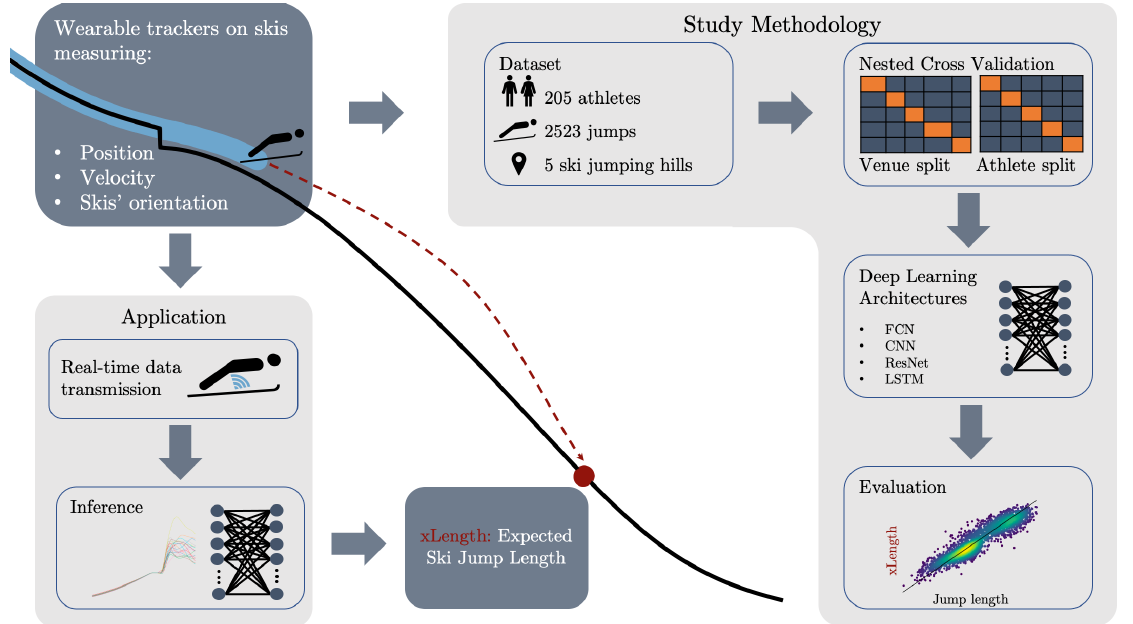
Figure 1. Two wearable trackers are mounted on the athletes’ skis. They measure the 3D position, 3D velocity, and 3D orientations of the skis. In a later application, the data are transmitted in real time and are used to predict the expected jump length (xLength) using deep learning. Additionally, the pipeline of the study methodology is